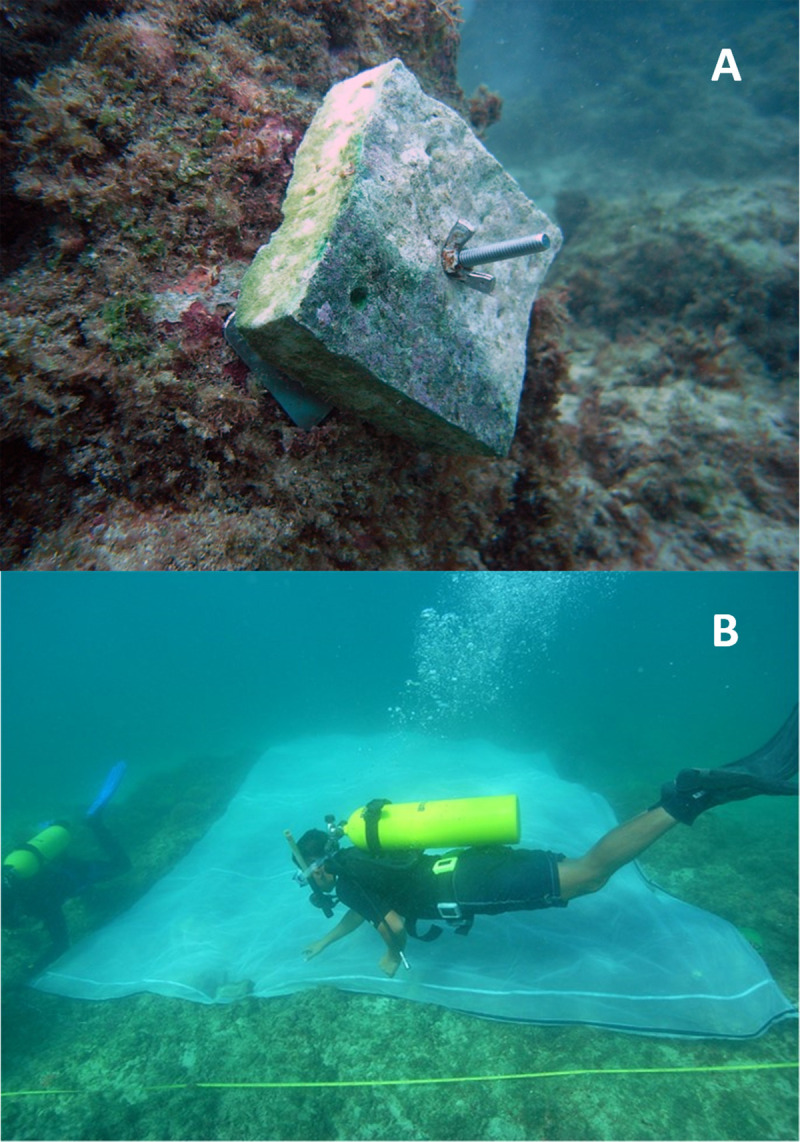
(a) Sample dead coral tile deployed in larval-enhanced and control plots used to determine initial larval settlement. (b) The mesh matting placed onto the larval enhancement plot.